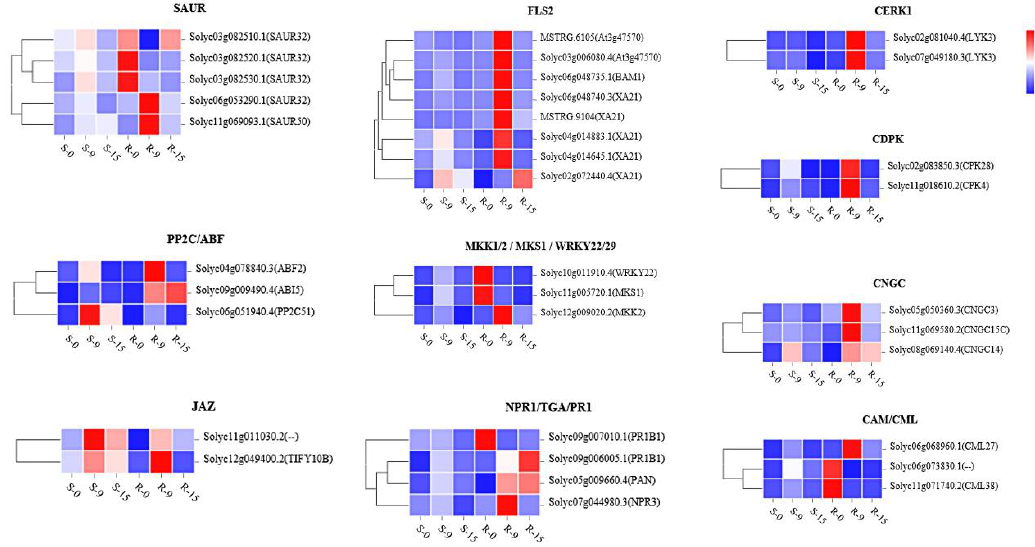
Figure 9. Expression patterns of genes a certain number of days after inoculation.